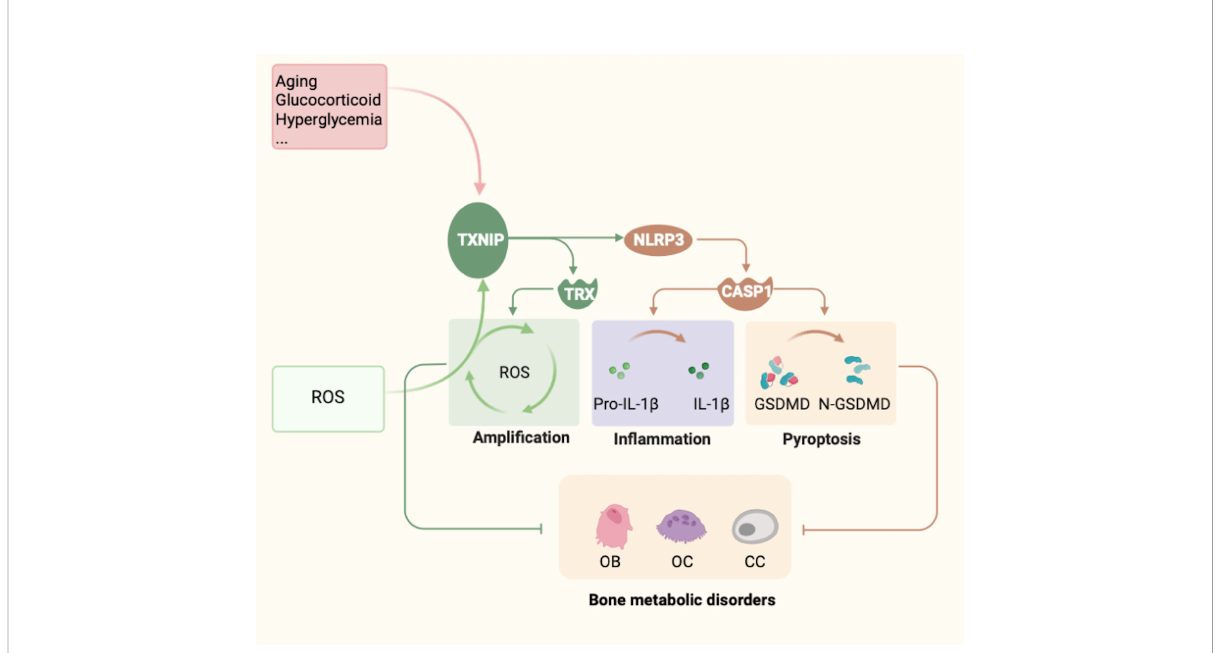
FIGURE 5 Summary of TXNIP regulation and functions. Several factors, such as glucose, glucocorticoids, metals, and aging, are known to regulate the expression of TXNIP. In contrast, TXNIP induces the emergence of oxidative stress, leading to the release of a large amount of ROS and amplifying the body ’ s oxidative stress response. However, owing to changes in the expression of TXNIP, three main effects can be noted: (1) The formation and function of the TXNIP – TRX complex. (2) TXNIP functions as a potential binding partner of NLRP3. TXNIP dissociates from